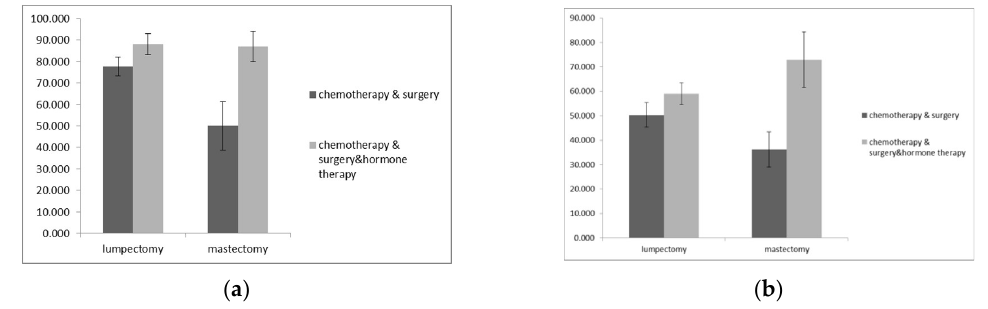
Figure 1. ( a ) Mean bodily pain scores according to treatment type across the surgery groups. Error bars show the standard error of the mean; ( b ) mean vitality scores according to treatment type across the surgery groups. Error bars show the standard error of the mean.